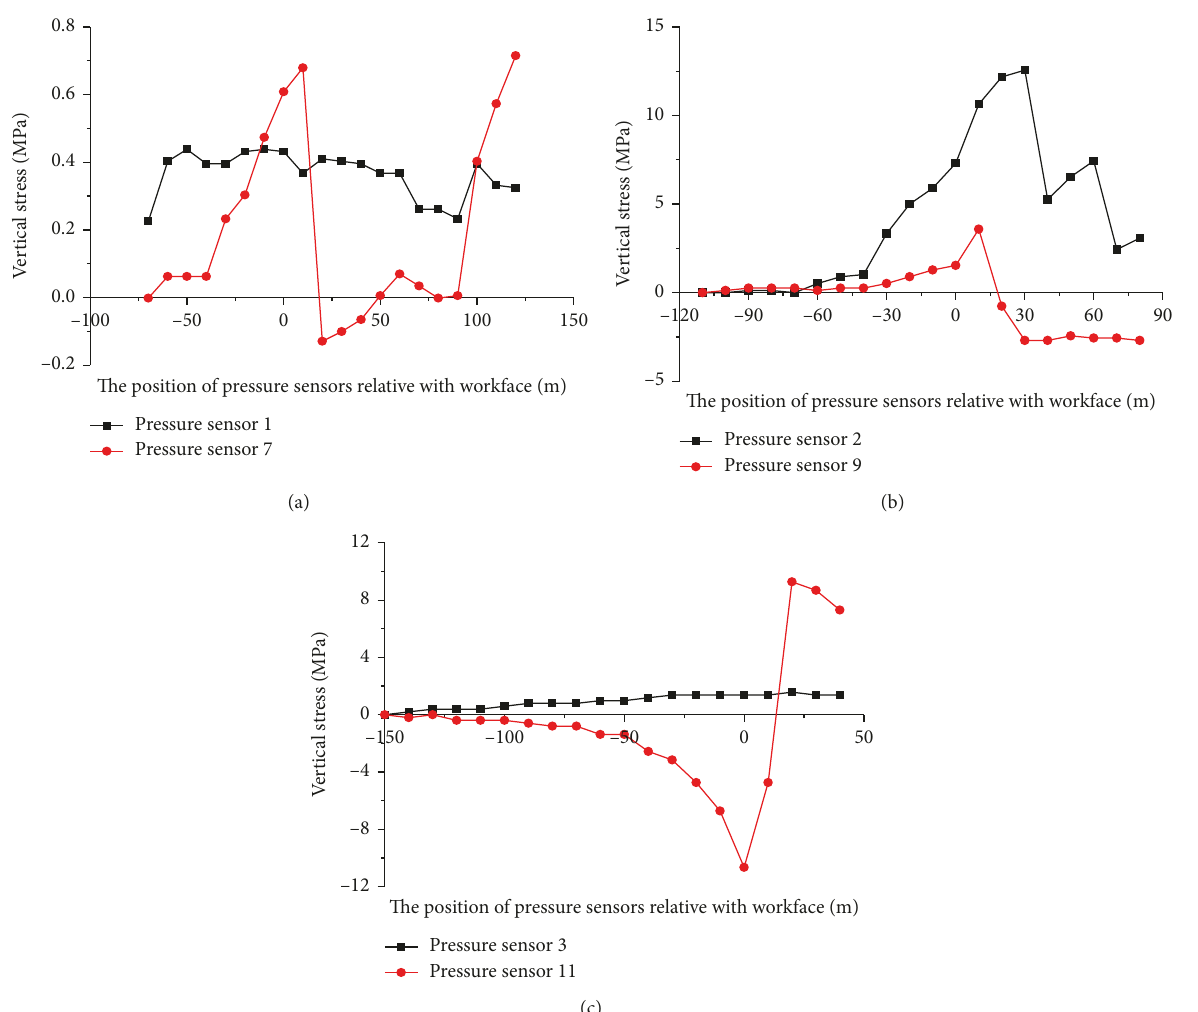
Figure 4: The distribution rules of stress in the overlying strata during excavation. Pressure sensors (a) 1 and 7, (b) 2 and 9, and (c) 3 and